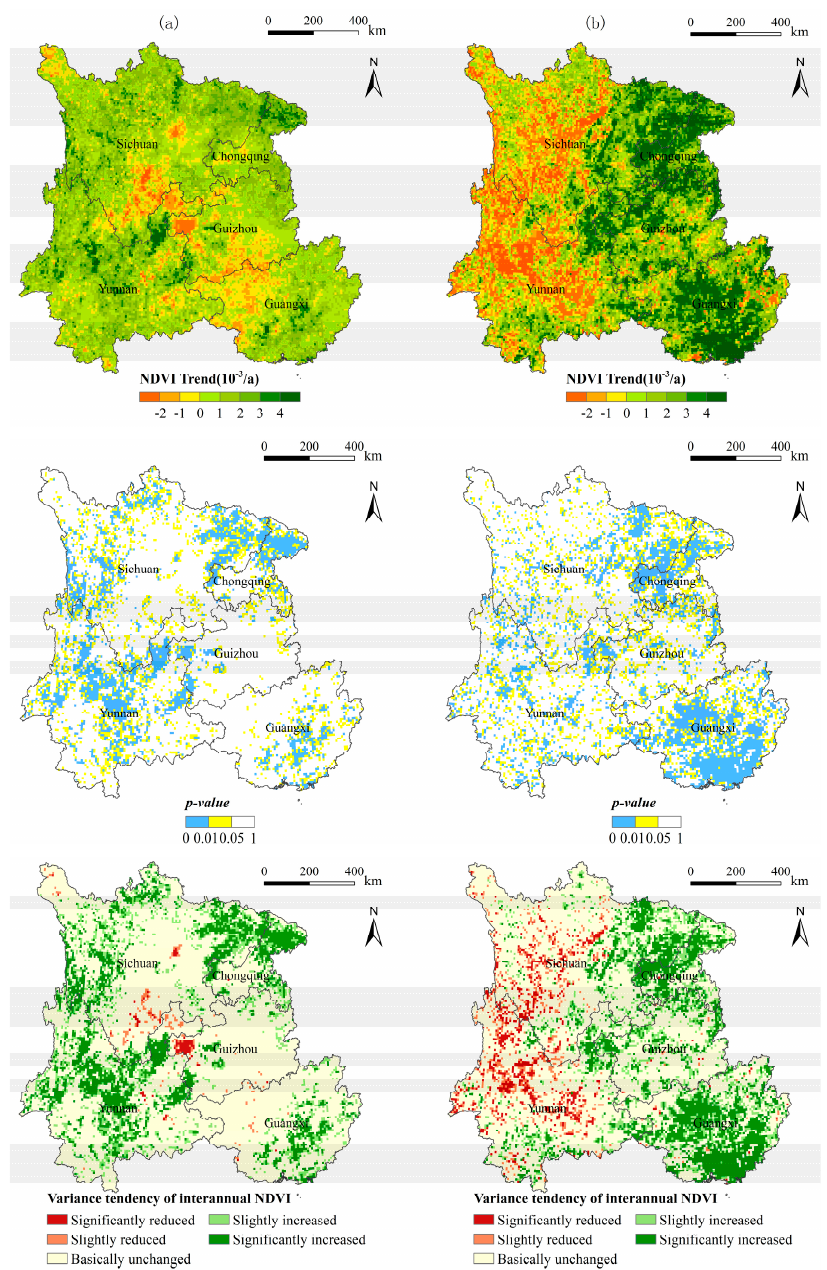
Figure 13. Comparison of spatial trend, the associated significance test and variance tendency over Southwest China between 1982–2000 ( a ) and 2001–2015 ( b